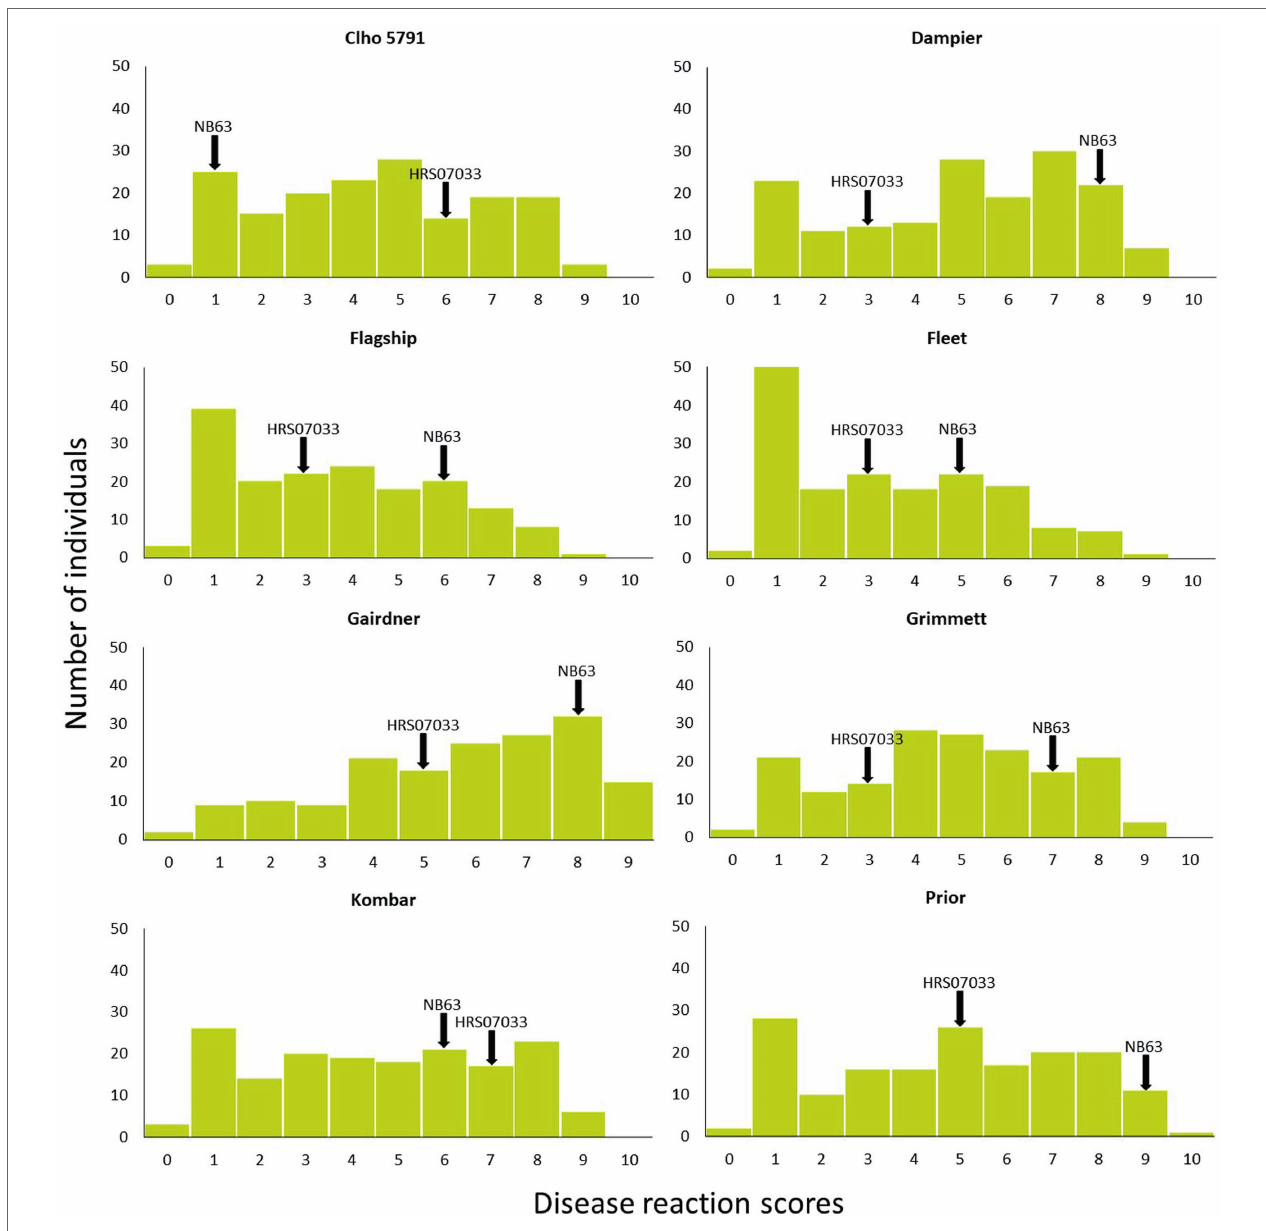
FIGURE 1 | Disease reaction scores of progeny isolates of Pop37 on eight barley cultivars/lines used in QTL analysis. Disease reaction scores of parental isolates are indicated with